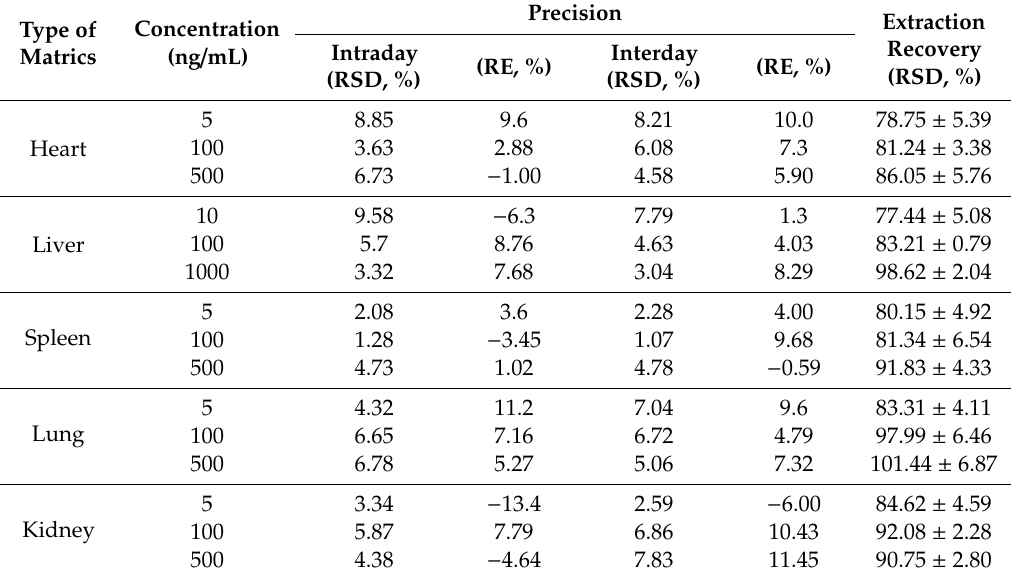
Table 2. Precision, accuracy, and recovery of ultrahigh-performance liquid chromatography-tandem